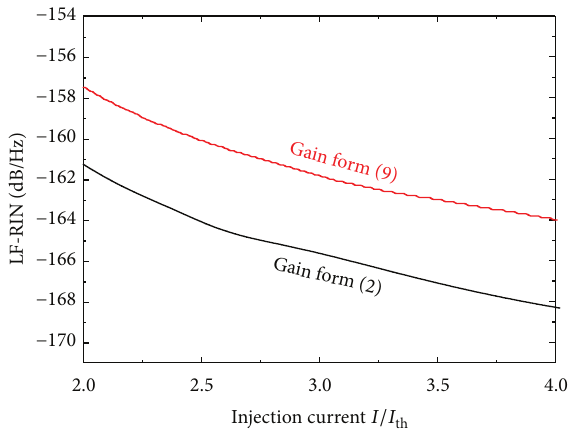
Figure 7: Dependence of LF-RIN on the injection current 𝐼/𝐼 InGaN lasers under partial homogeneous gain broadening (form (2)) and inhomogeneous gain broadening (form